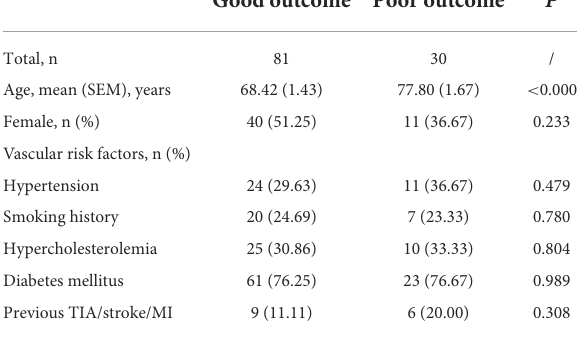
TABLE 4 Demographic and clinical characteristics of good and poor outcome samples.